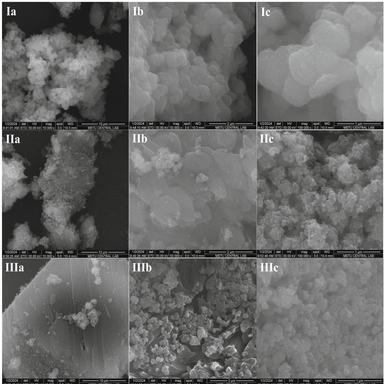
SEM image of (I) Ti-TPA-Si, (II) Ti-TPA-Si-C, and (III) Ti-TPA-Si-CS with the magnification of (a) 10,000, (b) 50,000, and (c)100,000, respectively.